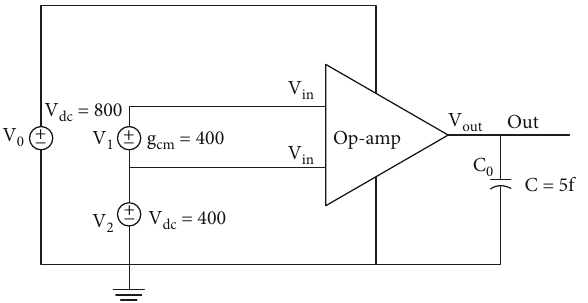
Figure 8: Two-stage OP-Amp with gain enhancement AC